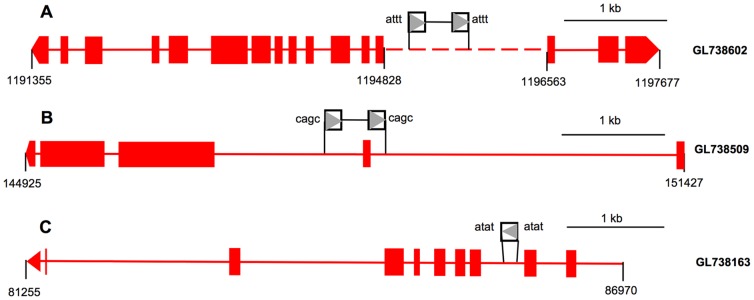
Examples of PbTRIM elements and solo-LTRs located within or near genes.Exons of predicted genes are shown as red boxes, with the last exons denoted as pentagons to indicate the transcription orientation. The solid and the dashed lines represent gene introns and intergenic regions, respectively. The direction of the LTR sequences is indicated by the grey triangles in the open square, and the TSD sequences are shown on the either side of the element or solo-LTR. (A) A complete PbTRIM element is located within 1-kb from the transcription start sites of two genes (upstream: protein SERAC1, downstream: GTP-binding protein ypt7). (B) A complete element contributes sequence to the second exon-intron boundary of the gene encoding SET and MYND domain-containing protein 4. (C) A solo-LTR is located within the first intron of a gene encoding the focal adhesion kinase 1.